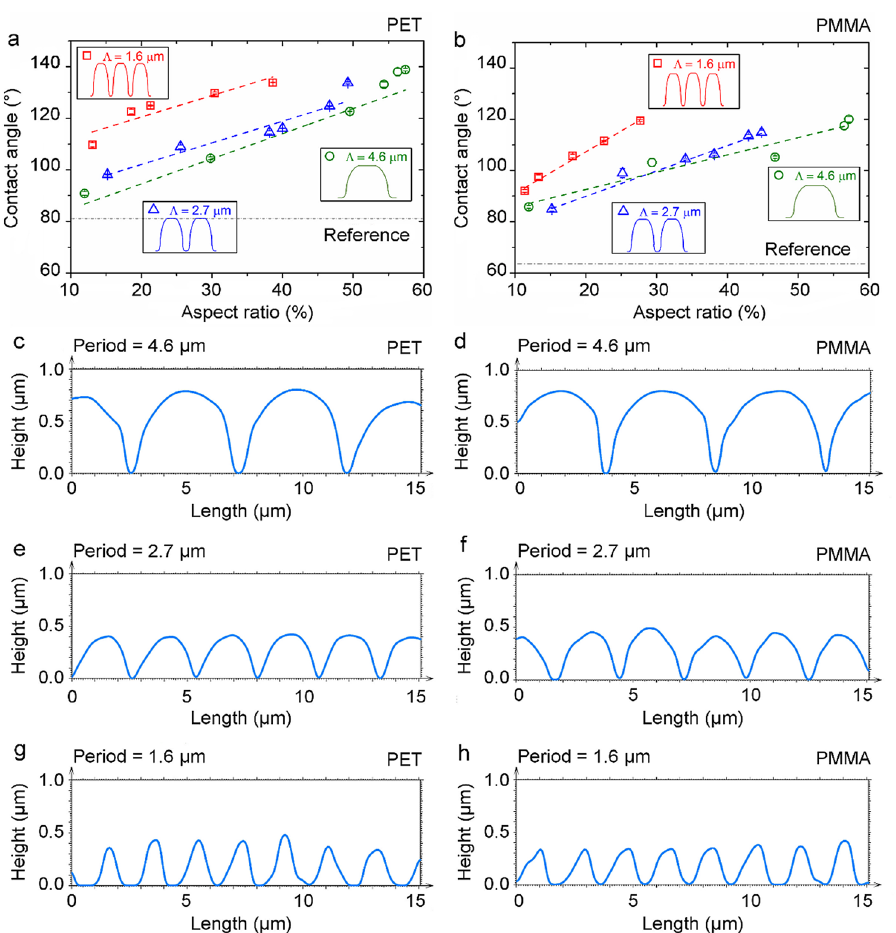
Figure 4. Static contact angle of water as a function of the aspect ratio of the imprinted pillar-like structures on ( a ) PET and ( b ) PMMA. The reference (grey) lines correspond to the water contact angle on the smooth original polymer surfaces, whereas the colored dashed lines represent linear fits to the data. Topographical profiles of ( c , e , g ) patterned PET and ( d , f , h ) PMMA with a spatial period of ( c , d ) 4.6 μm, ( e , f ) 2.7 μm, and ( g , h ) 1.6 μm,